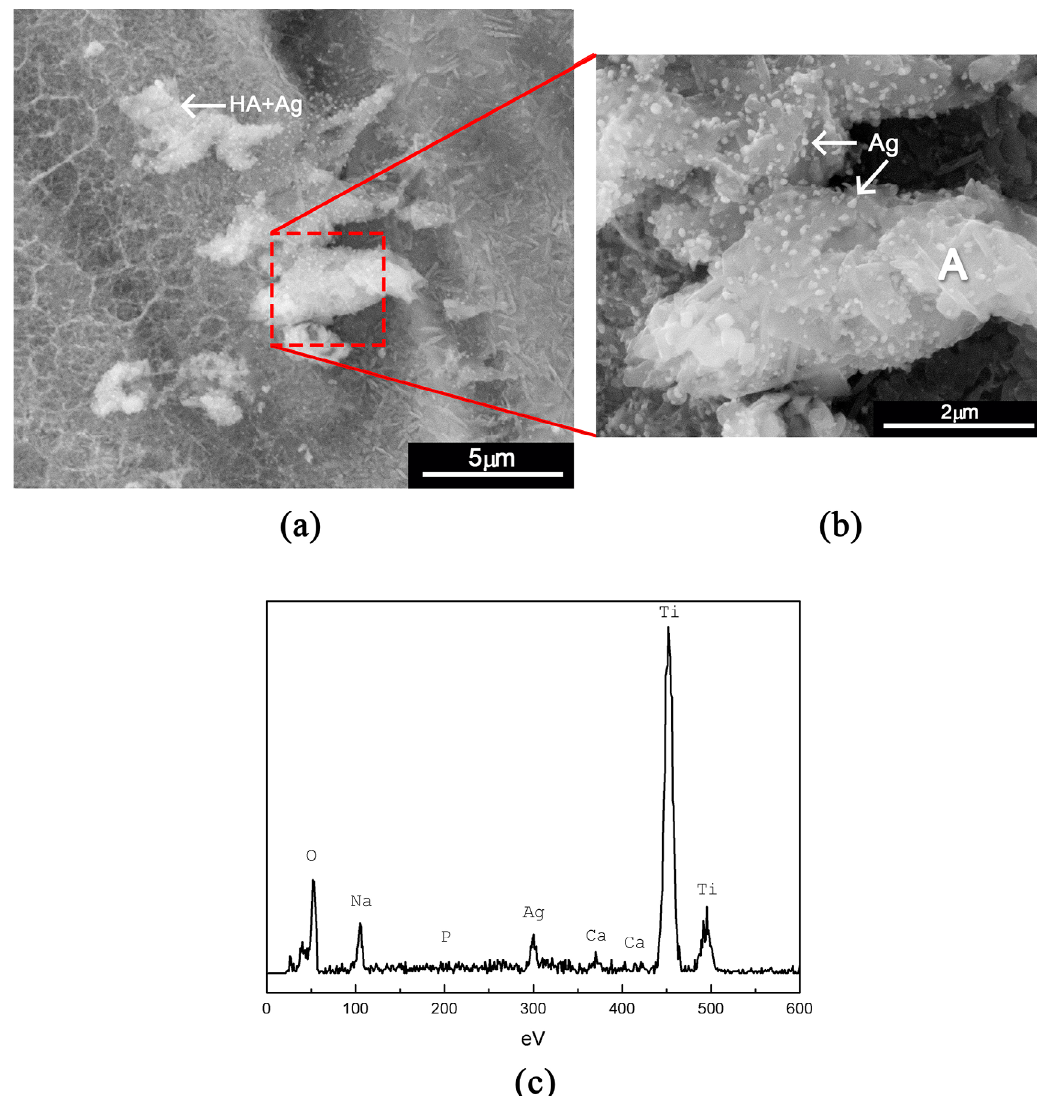
(a, b) and (c) spectrum obtained in the microanalysis of EDX at point 3